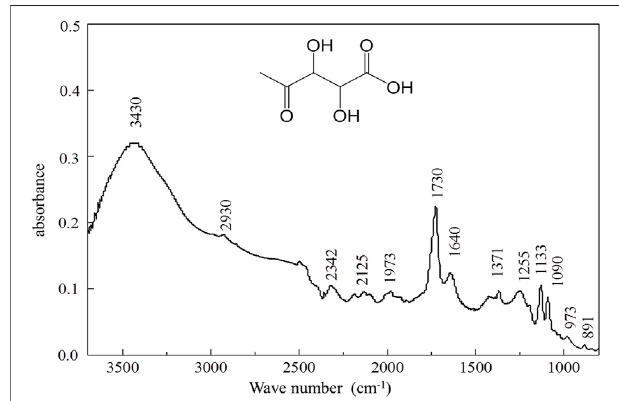
FIGURE 5 | Infrared absorption spectrum of DHOPA at room temperature.